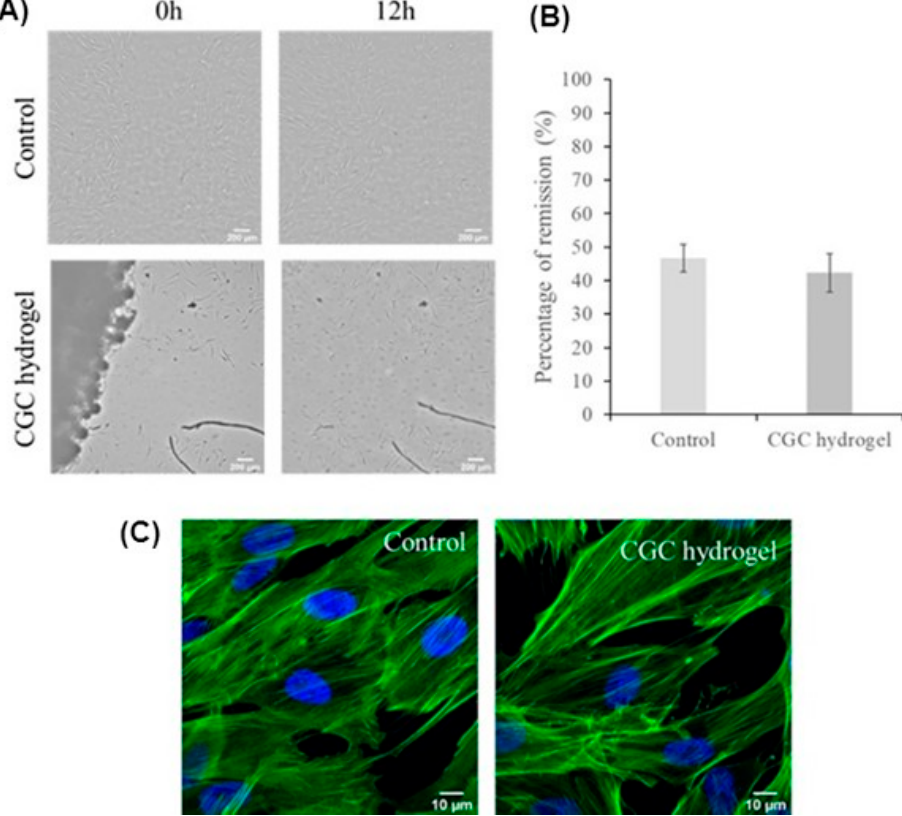
Figure 9. Representative images of the wound healing assay ( A ) at 0 h and 12 h after performing a scratch in a fibroblasts monolayer in the presence of a CGC hydrogel (CGC hydrogel) or absence (control); percentage of remission ( B ) after 12 h exposure to CGC hydrogel, or untreated (control). Bars represent the mean ± SEM of two independent experiments. Aspect of fibroblasts ( C ) in the absence (control) or presence (CGC hydrogel) of the CGC hydrogel. Cells were exposed for 12 h to the freeze-dried CGC hydrogel sample, fixed with 4% ( w / v ) formaldehyde, and then actin filaments were stained with phalloidin conjugated with AlexaFluor 488 (green fluorescence) and nuclei stained with Hoechst 33258 (blue fluorescence). The presented images are representative of five images acquired with a Zeiss LSM710 confocal